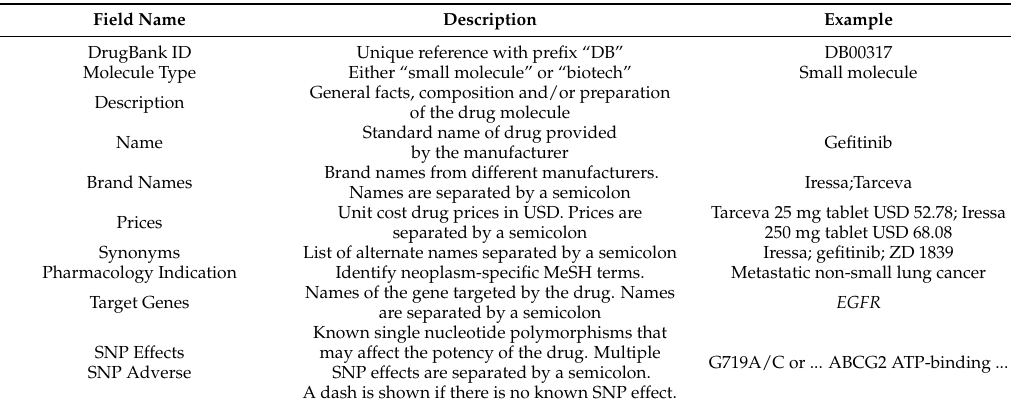
Table 3. List of fields in DrugBank targeted by our